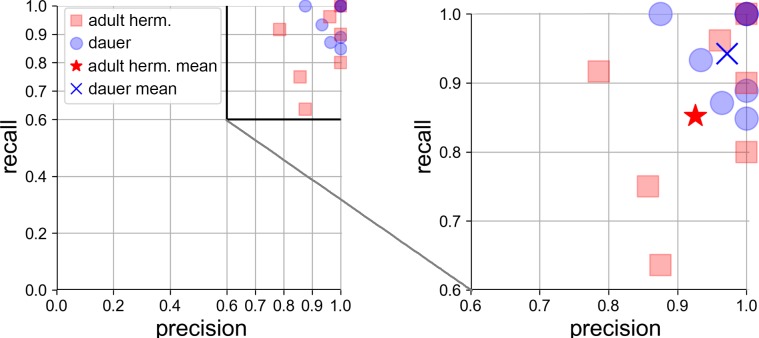
SVM error rates as precisionDCV and recallDCV plot.Each data point represents one validation tomogram. Red squares: adult hermaphrodite, blue circles: dauer larvae. Right: magnified detail plot. Red star indicates mean of hermaphrodite data: precisionDCV = 0.93, recallDCV = 0.85. Blue cross indicates mean of dauer data: precisionDCV = 0.97, recallDCV = 0.94. 3 dauer tomograms and 1 hermaphrodite tomogram were classified without error.